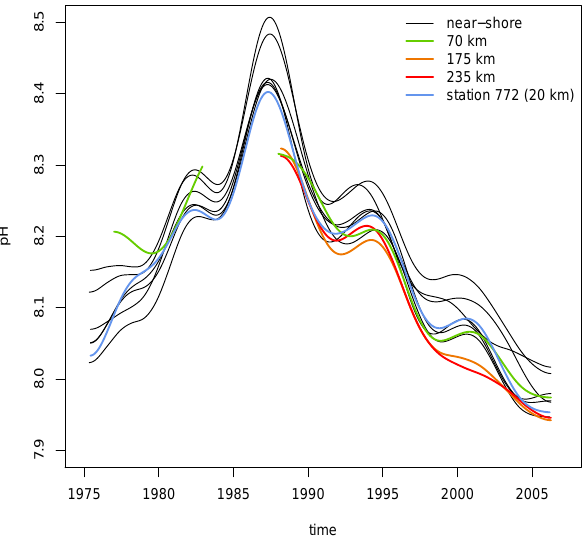
Fig. 3. Long-term (MODWT D6+D7+D8+S8) signals from all North Sea stations with more or less continuous data. Colors depict the distance from shore, the signal from the selected station 772 is shown in